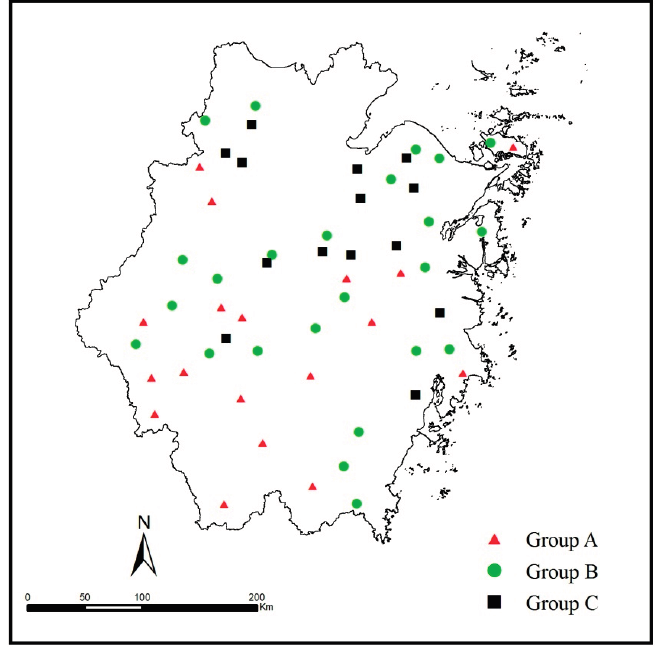
Figure 2. The spatial distribution of reservoir water